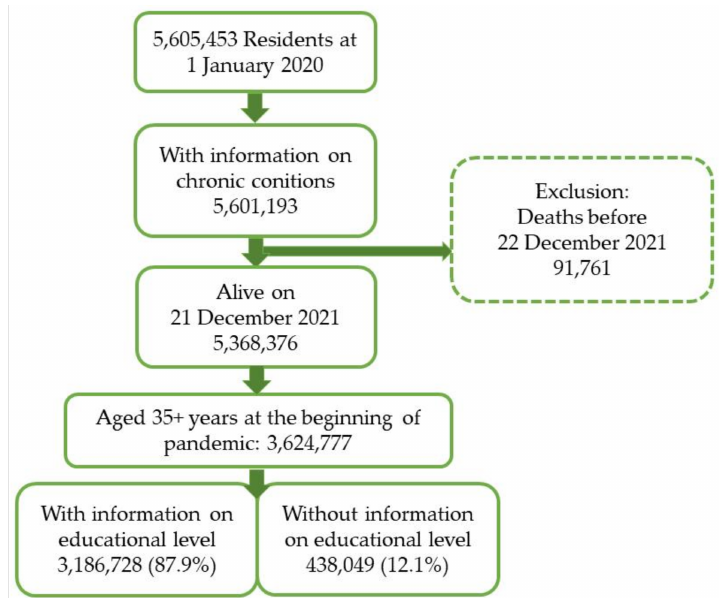
Figure 1. Flow chart of the study population